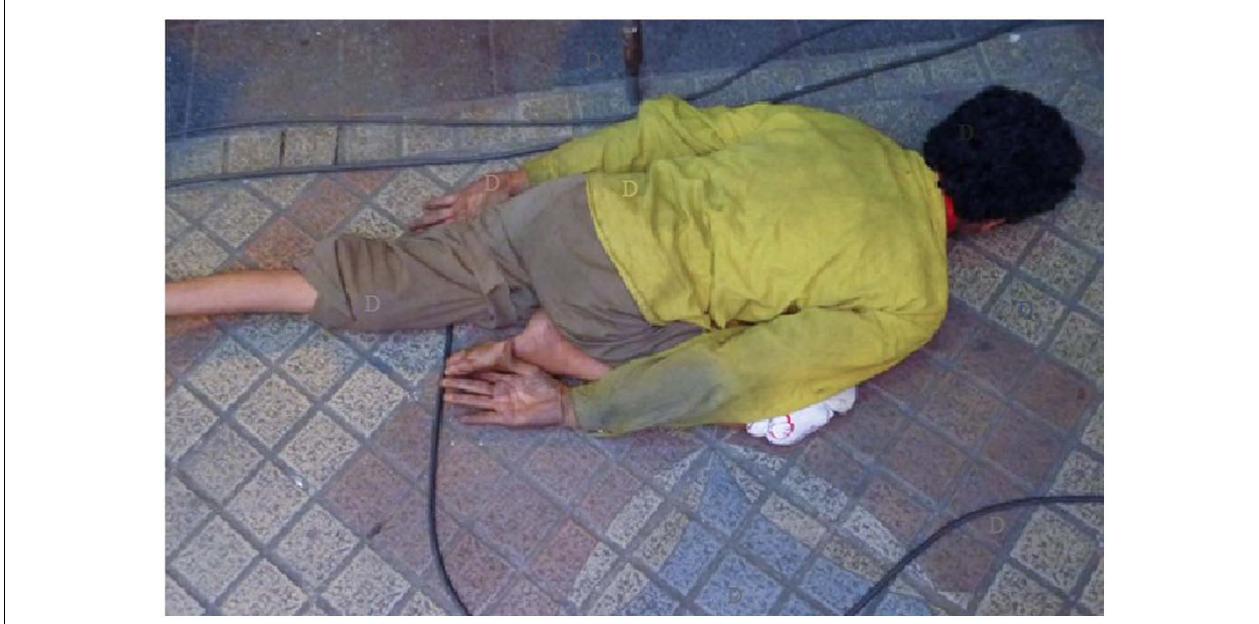
FIGURE 1 |An example of picture used for the “search” negative condition. In this trial participants were asked to count as many “D”s as they can. Letters were superimposed on the original picture.